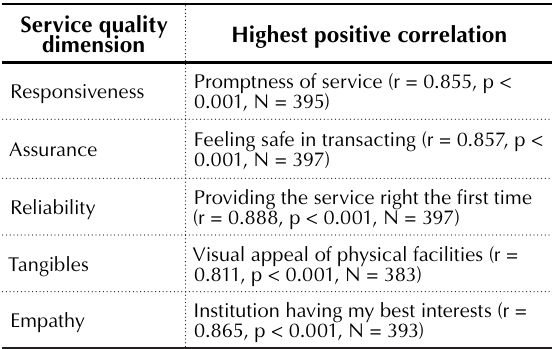
Table 8. Relationship between the importance of the service quality dimension and their related measurement